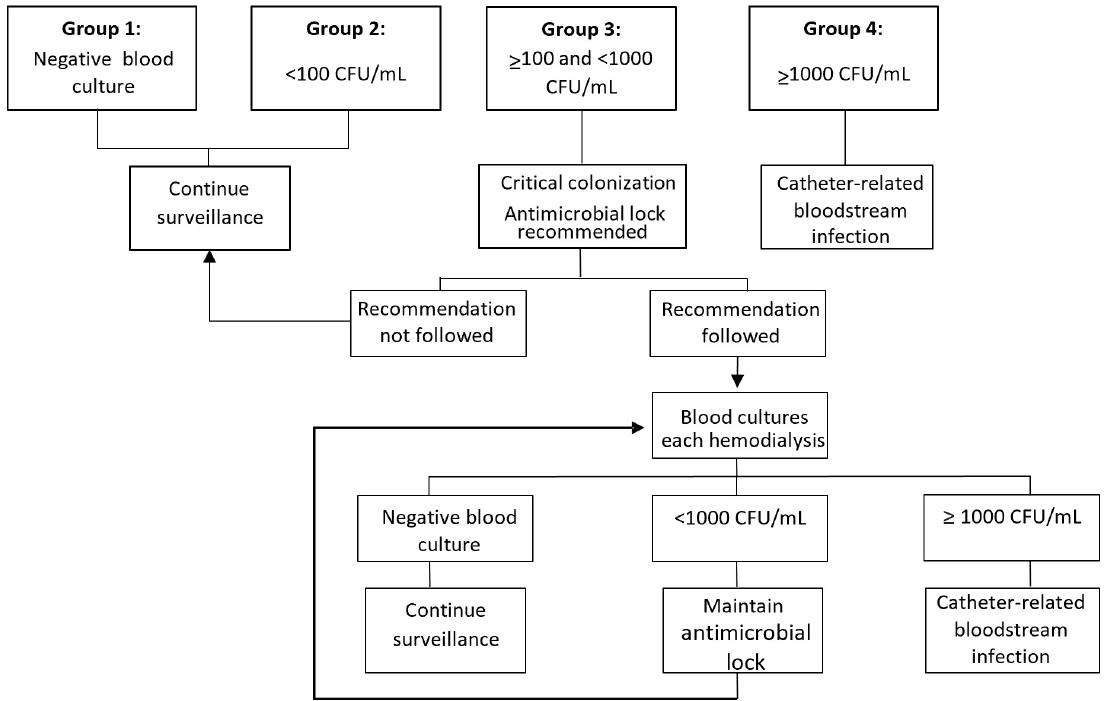
Figure 1. Algorithm for management of quantitative blood cultures results. Abbreviations: CFU, colony-forming unit; mL, milliliters.